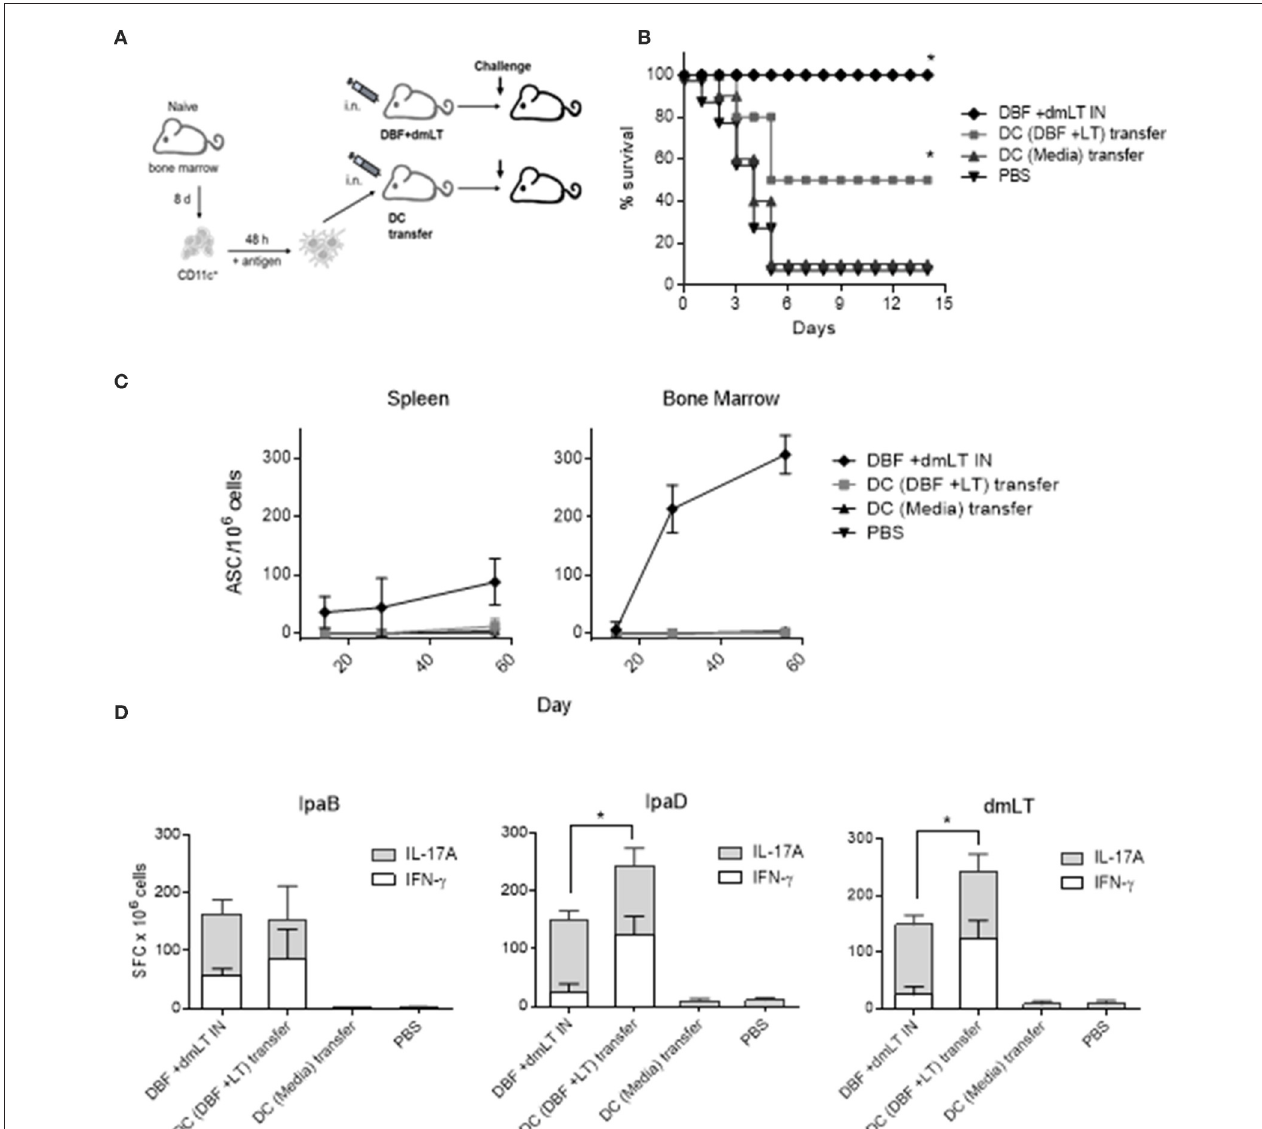
FIGURE 6 | Adoptive transfer of DCs. (A) Immunization layout employed for transfer experiments. (B) Dendritic cells stimulated with PBS, or the combination DBF + dmLT for 48h were administered intranasally to mice. Mice ( N = 10) were challenged with 2 × 10 7 CFU of Shigella flexneri 2457T. Animals immunized three times intranasally with DBF + dmLT or PBS were used as positive and negative controls, respectively. Survival was monitored for 14 days. ** p < 0.01 compared to survival of mice vaccinated with PBS using log-rank Mantel-Cox test, n.s. not significant. (C) Splenocytes and bone marrow cells from mice that were transferred DCs or vaccinated with protein were used in an ELISpot measuring IgG secreting cells specific for the DBF chimeric portion IpaB. (D) Splenocytes were stimulated with IpaB, IpaD or dmLT for 48h. cytokine-secreting cells were determined by ELISpot. IFN- γ and IL-17A spot forming cells (SFC) were counted and bar graphs show the differential amounts present for each treatment. Each bar represents the mean and SD of biological replicates (five individuals/group). Statistical significance was analyzed with a 2-way ANOVA with a Sidak post-hoc test. All comparisons tested with an α value of 0.05. * p < 0.05 in the frequencies of IFN- γ secreting cells.